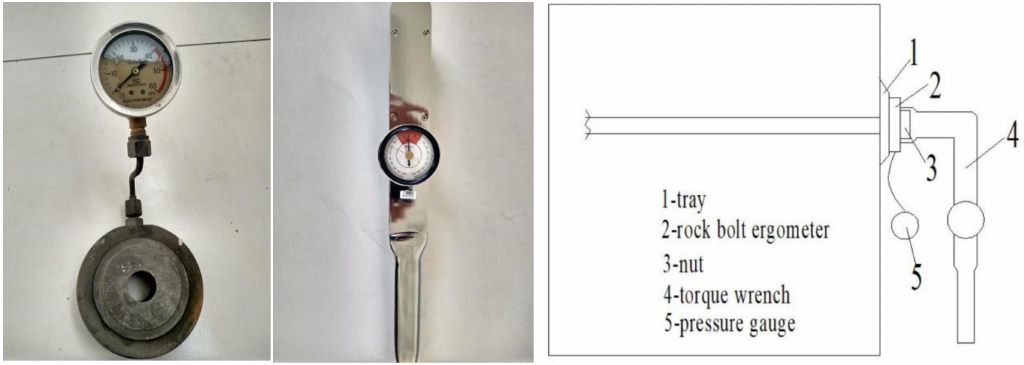
Figure 5. Test on torque-pretightening force of